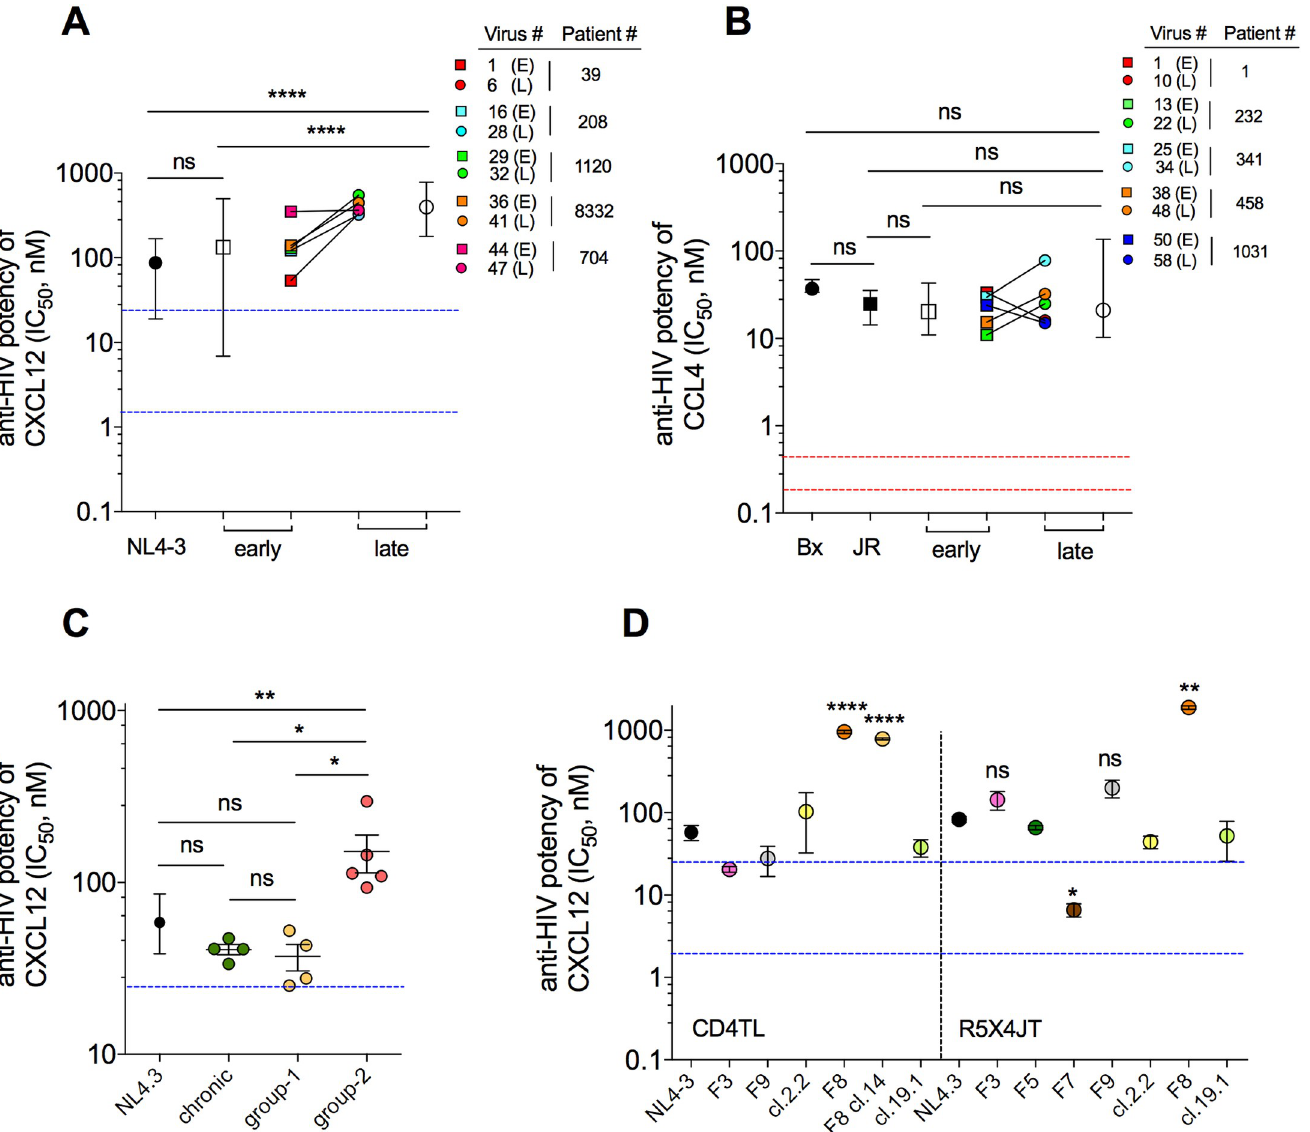
Fig 1. CXCL12 resistant viruses are frequent in patients with low CD4 T-cell count. A Viruses pseudotyped with early (E) or late (L) X4 Envs from 5 patients of the ACS were used to infect CD4TL w/or w/o CXCL12 at increasing concentrations. Mean ( ± range) (open symbols) and individual (colored symbols) IC 50 s of CXCL12 are shown. The same color code as shown here is used throughout the article. Blue dotted lines represent the range of CXCL12/CXCR4 affinities. The X4 HIV-1 strain NL4-3 was used as control. B Mean and individual IC 50 s for neutralization by CCL4 of viruses pseudotyped with early (E) or late (L) R5 Envs from 5 patients of the ACS. Red dotted lines represent the range of CCL4/CCR5 affinities. The JR-FL and Bx08 strains are controls. C CXCL12-mediated inhibition of recombinant viruses pseudotyped with Envs from plasma of patients diagnosed at a chronic (green symbols) or late stage (yellow and red symbols) of infection. Group-2 and group-1 comprise Envs that are, or are not, more resistant to CXCL12 than NL4-3 or chronic Envs, respectively. Each data point represents the mean IC 50 of CXCL12 for neutralization of a given virus. D CXCL12-mediated neutralization of recombinant viruses expressing Envs isolated from plasma of patients at the time of PHI. Each data point is the mean IC 50 of CXCL12 ( ± SEM) for the indicated virus, calculated from independent experiments on CD4TL (left) and/or R5X4JT cells (right). Statistics are relative to